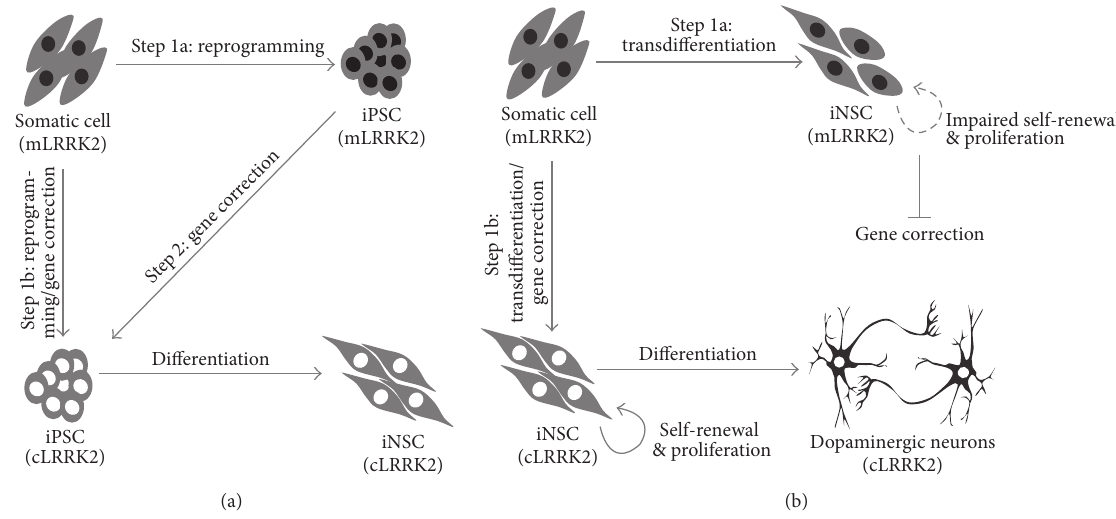
Figure 3: Application of the gene-correction approach in cells with the LRRK2 (G2019S) mutation. (a) Conventional gene-correction approachusingmutantiPSCsgeneratedfromLRRK2(G2019S)mutantfibroblasts,involvingreprogrammingwithsubsequentgenecorrection (Step 2 via Step 1 a), and the combined reprogramming and gene-correction approach based on LRRK2 (G2019S) mutant fibroblasts (Step 1 b). (b) Mutant iNSCs are generated from LRRK2 (G2019S) mutant fibroblasts, potentially exhibiting impaired self-renewal or proliferation in Step 1 a, whereas, in Step 1 b, transdifferentiation and gene correction occur simultaneously and the corrected iNSCs are capable of stable proliferation with maintained self-renewal